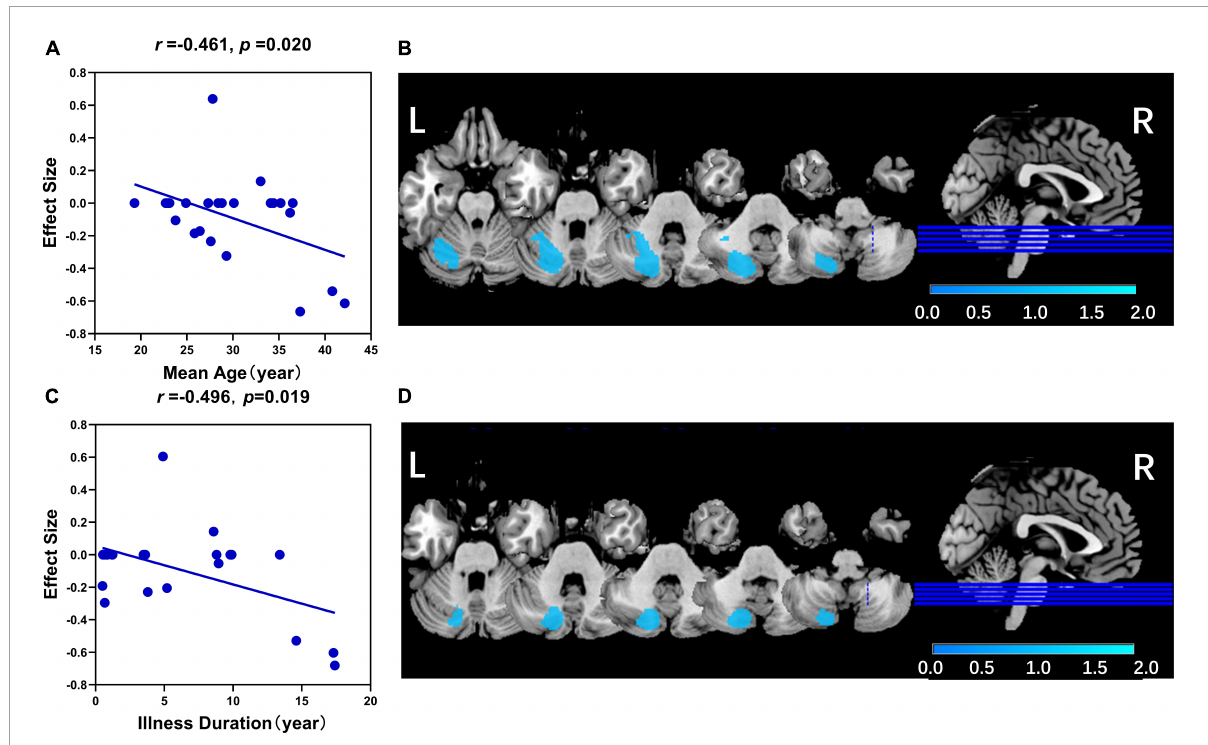
FIGURE3 The results of the meta-regression analysis. (A) The mean age was negatively associated with GMV in left Crus II in patients with schizophrenia ( r = –0.461, p = 0.020). (B) The related significant cluster of the left crus II in this meta-regression analysis of mean age. (C) The illness duration was negatively associated with GMV in left Crus II in patients with schizophrenia ( r = –0.461, p = 0.020). (D) The related significant cluster of the left Crus II in this meta-regression analysis of illness duration. In panels (A,C) , the effect sizes to create the plot were extracted from the peak of the maximum slope difference, and each study was represented as a dot (meta-regression signed differential mapping slope). In panels (B,D) , the decreased GMV in the left Crus II was shown in blue